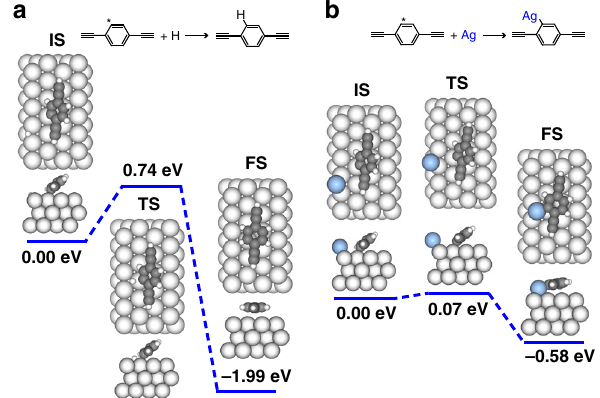
Fig. 8 Theoretical investigations of different reactivities of the debromination sites. DFT-calculated potential pathways on Ag(111) of a the coupling between an unpassivated DEB molecule and an H atom, and b the reaction between an unpassivated DEB molecule and a Ag